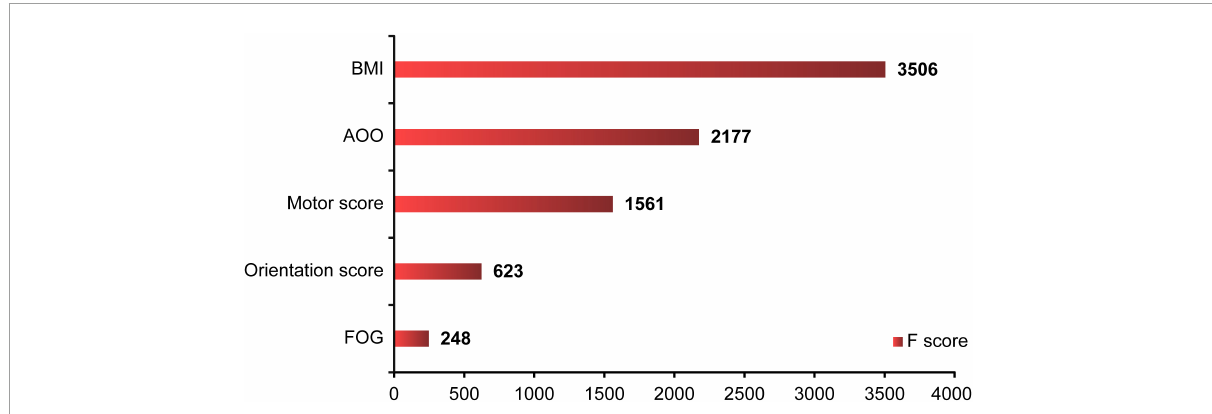
FIGURE5 XGBoost ML analysis of the importance of each variable. The XGBoost showed that BMI, AOO, motor score, orientation score, and FOG contributed to the model in various degrees, and the importance of each variable decreased in turn. F score: the importance of each factor. XGBoost, eXtreme Gradient Boosting; ML, machine learning; BMI, body mass index; AOO, age of onset; FOG, freezing of